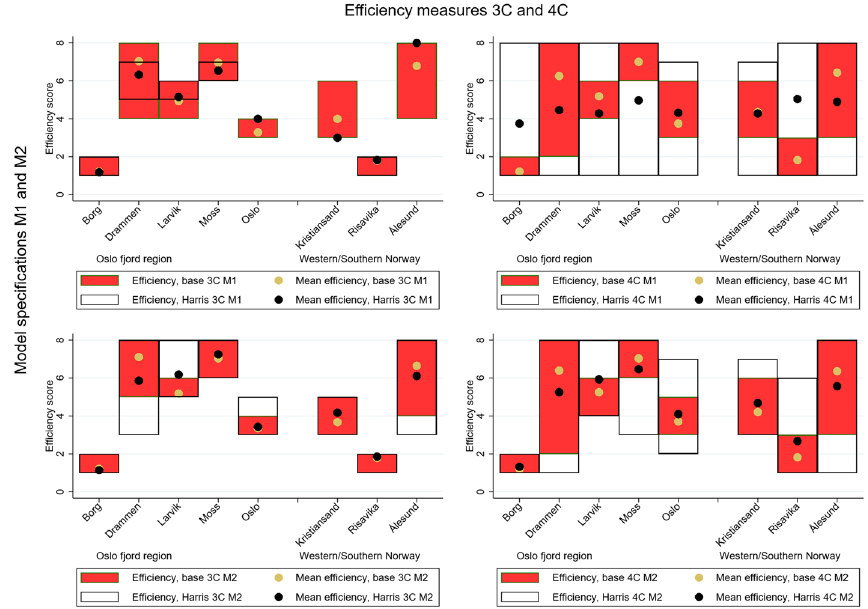
Fig. 5 Means and distributions of rankings per port for Harris measure model specifications with (M2) and without (M1) controls for unobservable intertemporal variations and efficiency measures 3C and 4C